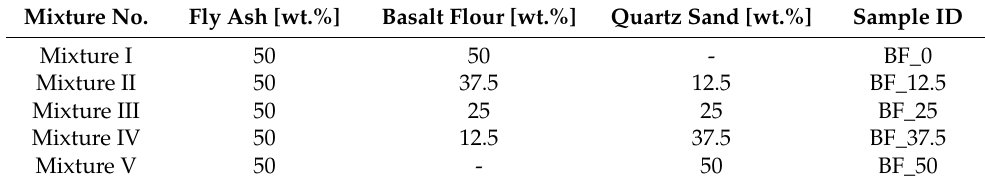
Table 2. Percentage of individual dry components in the mixtures used to produce geopolymers, along with designations. Mixture No. Fly Ash